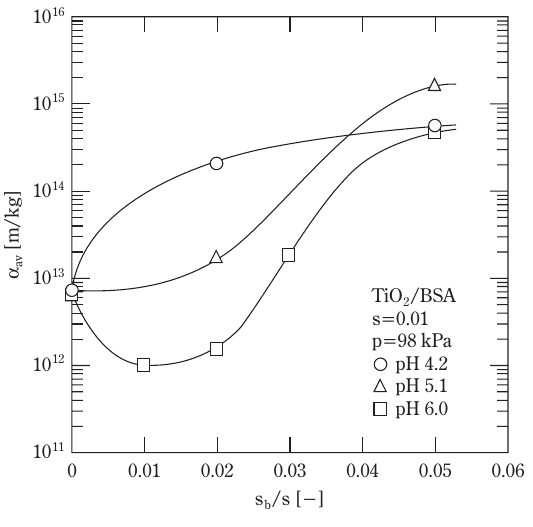
Fig. 22 Effect of salt addition on average specific filtration resis- tance in ultrafiltration of particle/protein mixtures.